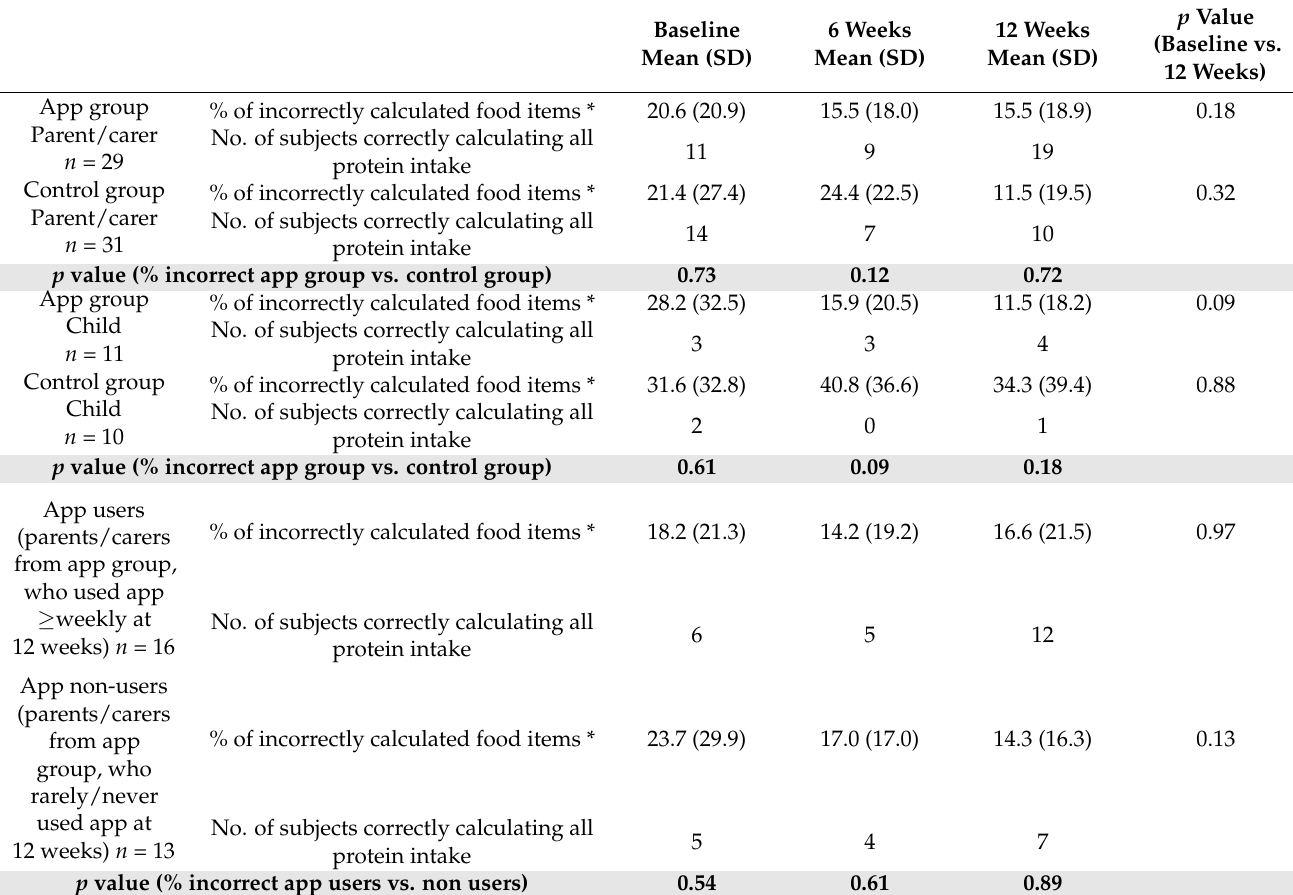
Table 7. Accuracy of calculating protein intake from diet